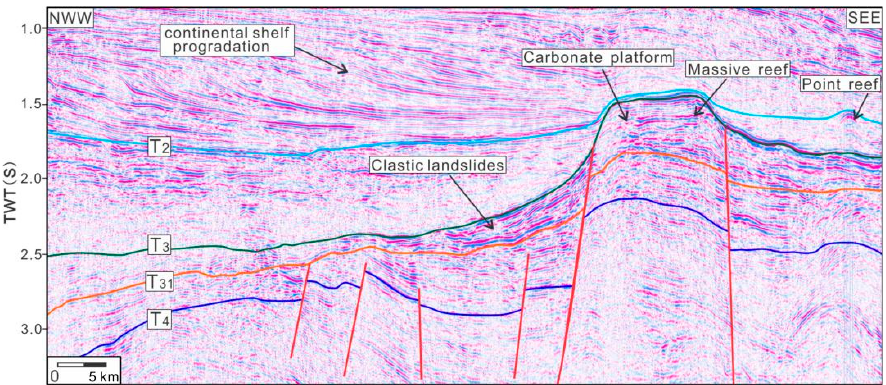
Figure 7. Seismic profile of RCPs in center of Wan’an Basin. Profile location is shown in Figure 2b.